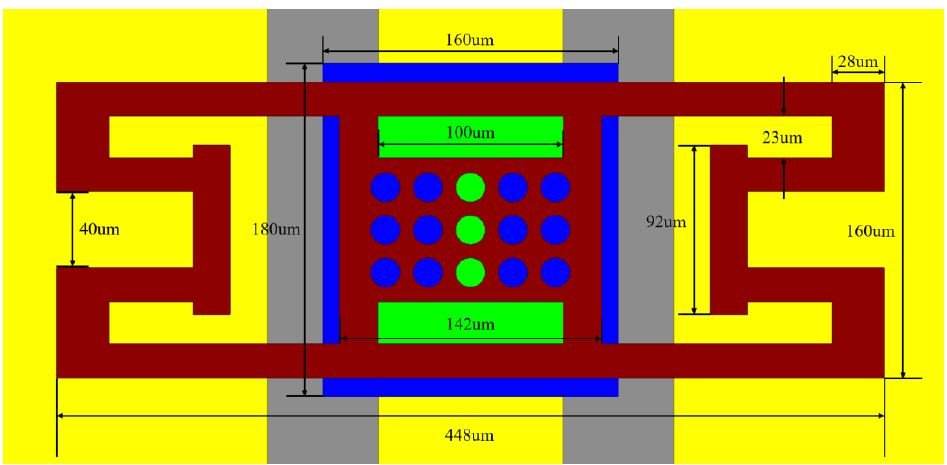
Figure 11. Physical dimensions of the suggested RF MEMS switch.